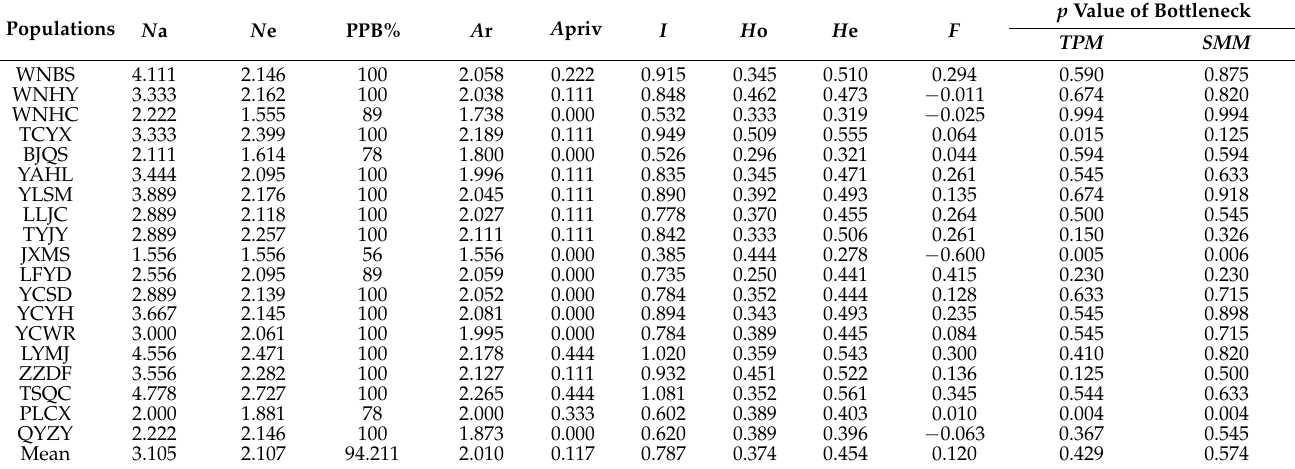
Table 3. Genetic variability statistics of 9 nSSR loci in 19 ancient P. orientalis